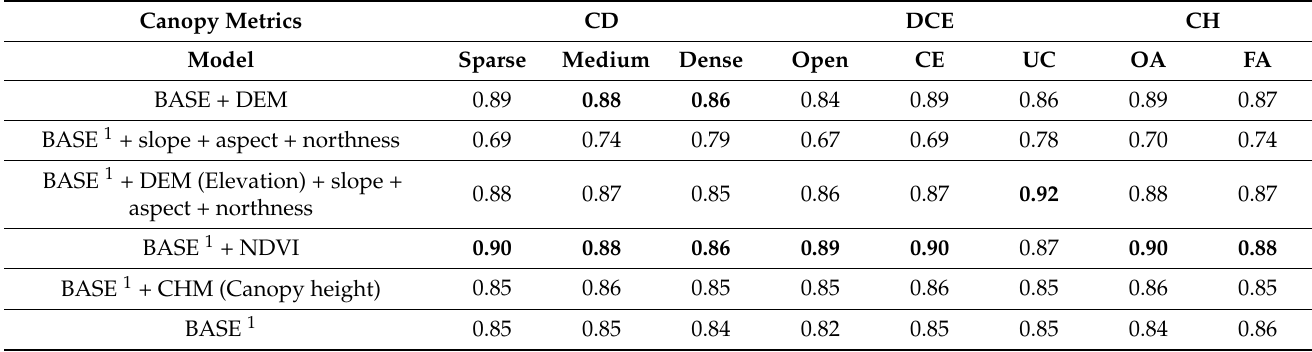
Table 2. Performance metrics (F-score) in forest classes delineated using different forest canopy metrics within the Gunnison site across all the models. CD = canopy density, DCE = distance to canopy edge, CH = canopy height, CE—Canopy Edge, and UC—Under Canopy. The results were derived from 19 PlanetScope scenes for the Gunnison area.